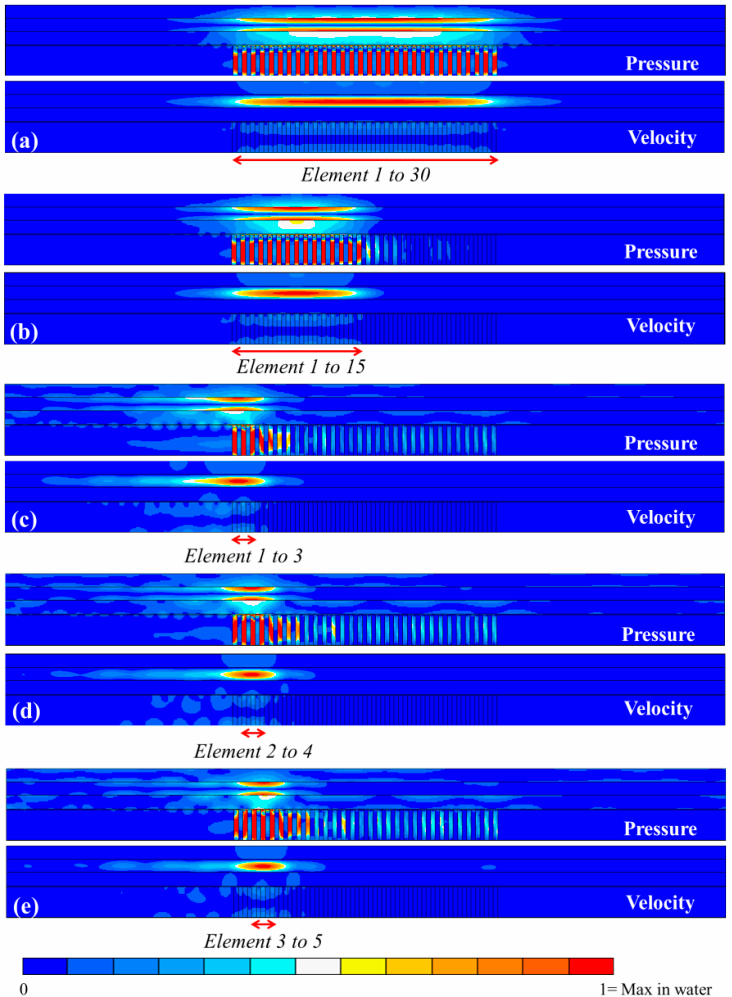
Figure 11. Pressure and velocity distributions of the 1-D array lateral: ( a ) all 30 elements active; ( b ) 15 elements active; and ( c–e ) sets of 3 elements active, shifted along the channel. The elements are driven at f . Each field is normalized to its own maximum 2 amplitude in the water. Red arrows and text indicate active